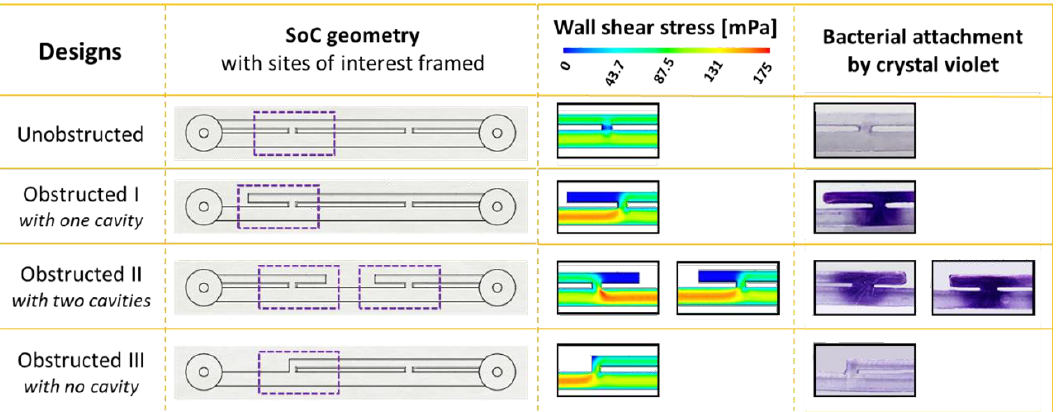
Figure 2. Bacterial attachment occurs in proximity to the hydrodynamic cavity formed by a ureteral occlusion. The unobstructed SoC device does not show evidence of bacterial attachment, as indicated by the absence of detectable crystal violet staining. The obstructed I SoC device (i.e., with one cavity) shows bacterial attachment in the cavity region, which corresponds to an area of low wall shear stress (WSS) and laminar vortices. The spatial distribution of WSS over the bottom surface of the devices (determined from computational fluid dynamic (CFD) simulations) and images of crystal violet staining are illustrated for those regions affected by bacterial attachment (purple frames). Average WSS values are generally relatively high (WSS ~ 133 mPa) inside the stent lumen and become significantly lower (WSS < 40 mPa) within side-holes in the unobstructed design and within the occluded cavity in the obstructed I design. However, crystal violet staining was only visible within the cavity. The SoC device named “obstructed II with two cavities” showed attachment of bacteria in both cavities, located both proximally and distally to the occlusion. The SoC device named “obstructed III design with no cavities” (i.e., with the obstruction located at the edge of the proximal side-hole) presented no visible attachment, suggesting that wall shear stress was not low enough to initiate bacterial attachment. CFD simulations showed low wall shear stress (WSS << 40 mPa) in both cavity regions for the obstructed II design, whereas it was always greater than 40 mPa in the obstructed III design.